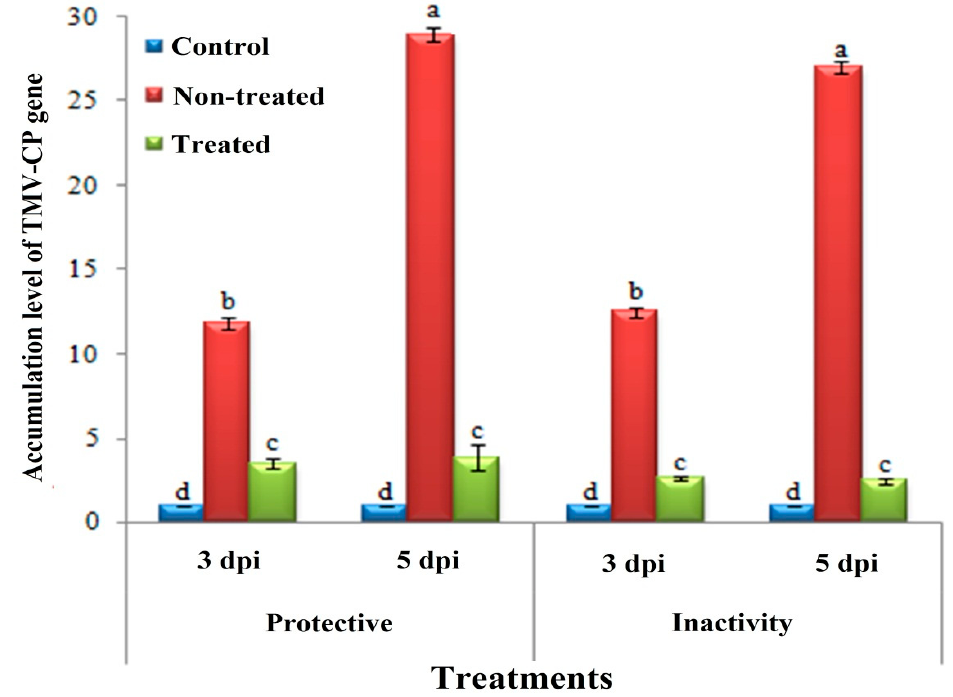
Figure 3. A histogram showing the accumulation levels of the TMV-CP gene at 3 and 5 days dpi with the protective activity and inactivity of H. tuberculatum WPE treatments (200 μ g/mL). Control = mock-treated plants; non-treated = plants inoculated with TMV only without any treatment; treated = plants treated with WPE, 24 h before inoculation of TMV for the protective assay and 24 h after inoculation of TMV for the inactivity assay. Columns represent a mean value from three biological replicates and the bars indicate the standard deviation (SD). Significant differences between samples were determined by one-way analysis of variance (ANOVA) using CoStat software. Means were separated by the least significant difference (LSD) test at p ≤ 0.05 and indicated by lowercase letters. Columns with the same letter do not differ significantly.